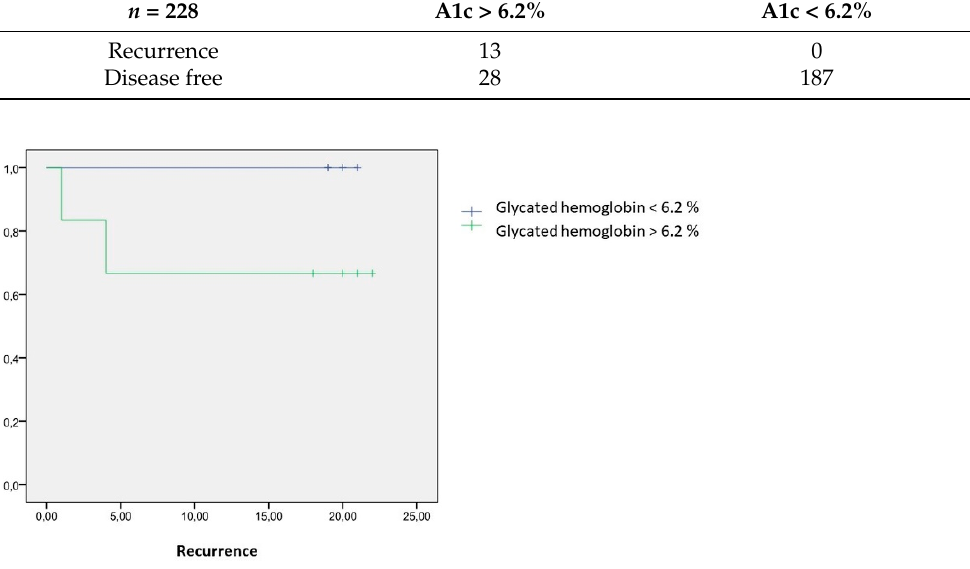
Figure 2 . Kaplan–Meier curve between preoperative glycated hemoglobin levels and recurrence after 24 months of follow-up. 24 months of